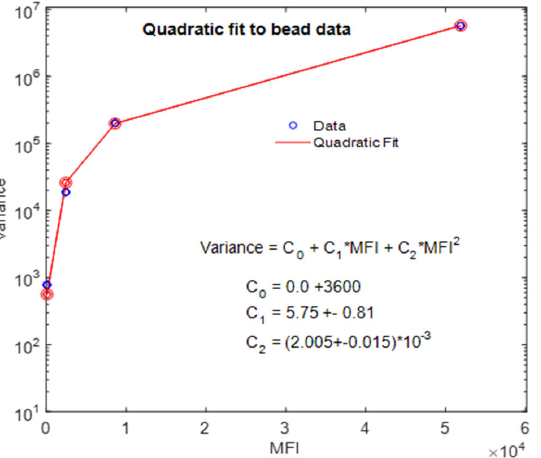
Figure 6. The blue circles show the measured values of the variance plotted against the corresponding values of MFI. The orange dots show the variance and MFI obtained from the model. In most cases, the orange circles overlay the blue circles. The red trace is the fit to a quadratic polynomial with the fitted function shown in the inset. The plot was made using data in Table 4.